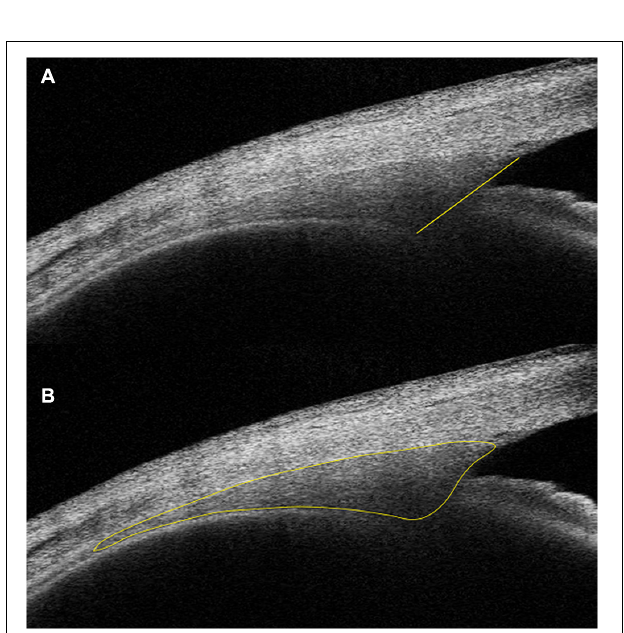
FIGURE 2 | Examples of IA-SS (A) and CMA (B) measurements. IA-SS, scleral spur to the inner apex of the ciliary muscle; CMA, cross-sectional area of the ciliary